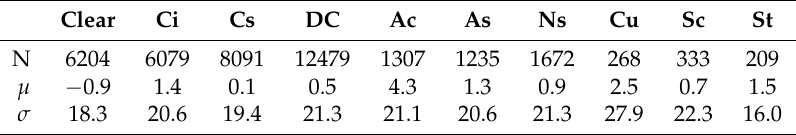
Table 3. The number of cases N, mean bias ( µ ) and uncertainty (RMS, σ ) of the ensembles and sub-ensembles of the FY4A humidity for the layer from 280 hPa to the surface and 9 ISCCP cloud types. The FY4A humidity is with a quality flag of “perfect” and “good” only. The units of bias and uncertainties are the absolute value of %. Ci: Cirrus, CS: cirrostratus, Ac:altocumulus, DC: deep convection, As: altostratus,Ns: nimbostratus, Cu: cumulus, SC: stratocumulus,